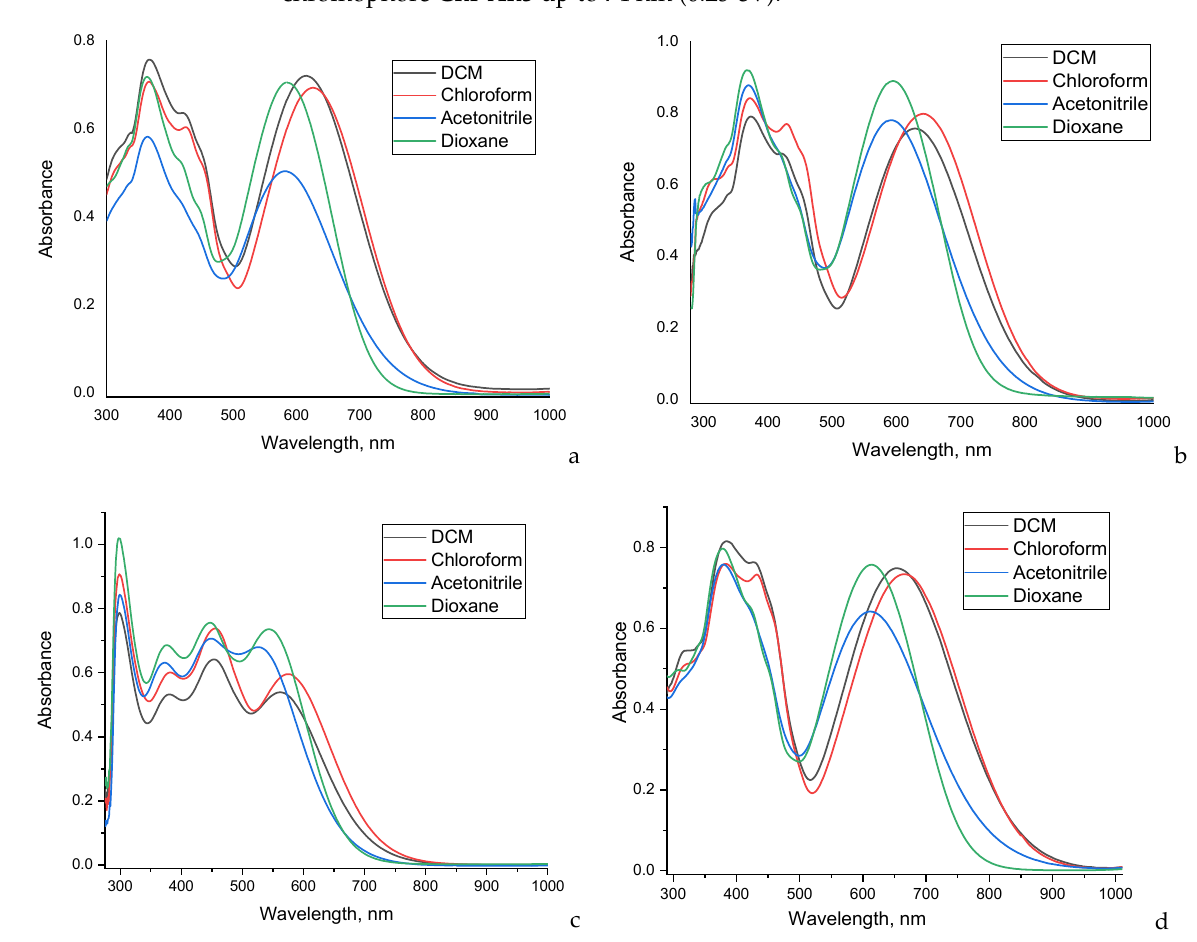
Figure 2. Experimental electronic absorption spectra of the chromophores Chr-An2 ( a ), Chr-An3 ( b ), Chr-PT ( c ) and Chr-TQ ( d ).